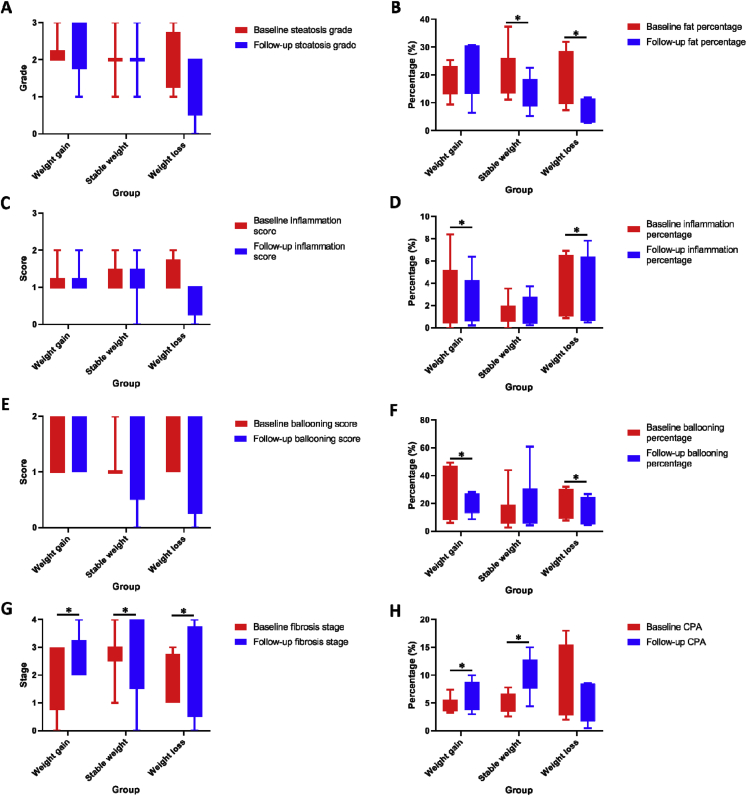
Comparison of key features from paired liver biopsy specimens, as assessed by the NASH-CRN scoring system and automated quantitation. (A) Steatosis grade; (B) fat percentage; (C) inflammation score; (D) inflammation percentage; (E) ballooning score; (F) ballooning percentage; (G) fibrosis stage; and (H) collagen proportionate area. The Mann–Whitney test was used to compare pre- and post-biopsies in all cases. ∗P < 05.